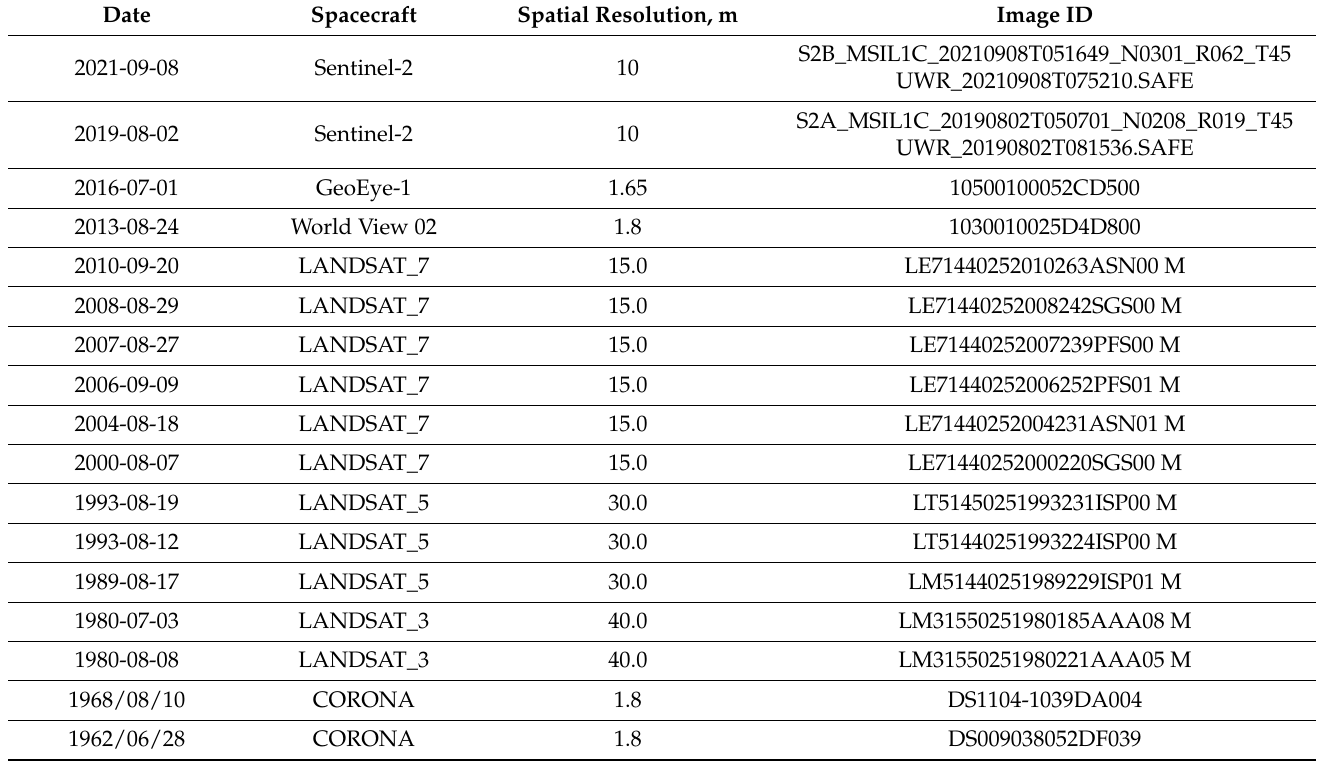
Table 1. Satellite imagery used in the